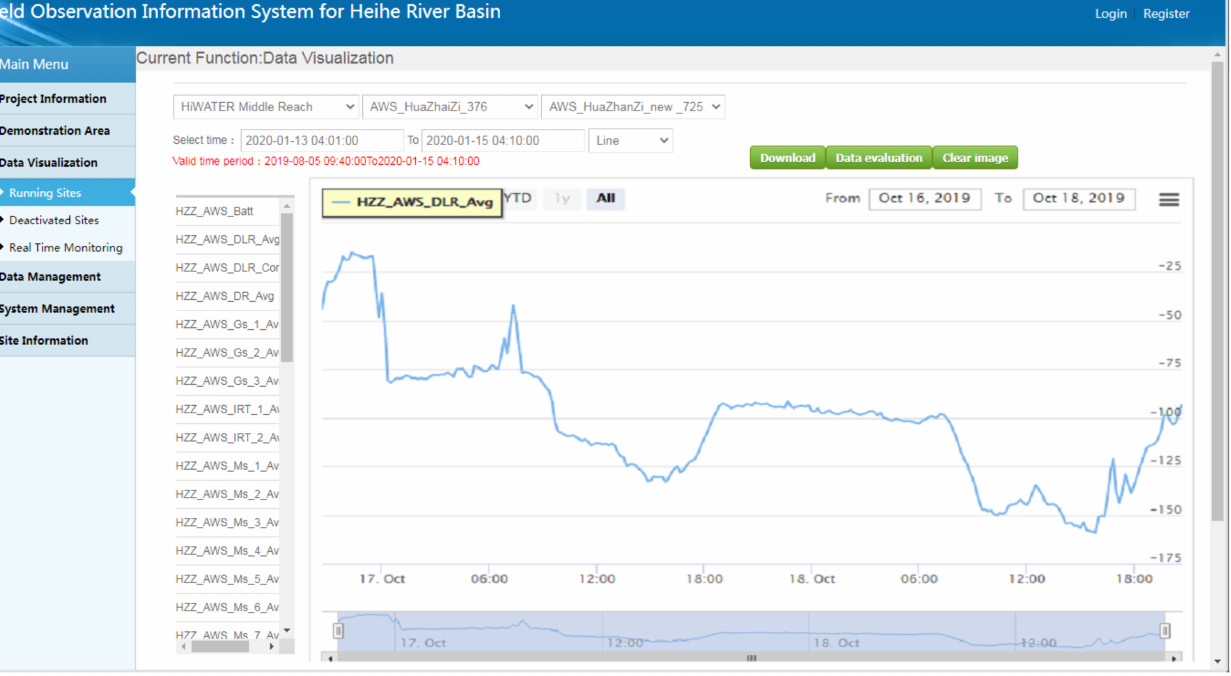
Figure 9. Data management and service interface of the IODCS of the HRB (translated from the user interface in